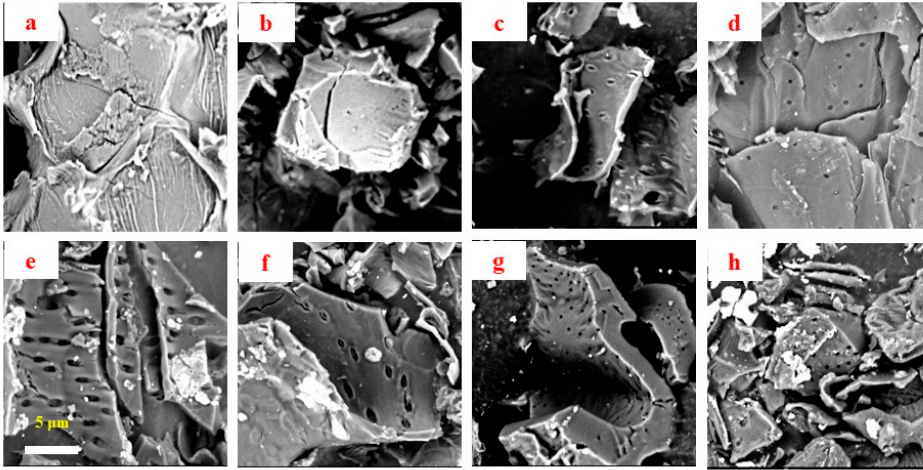
Figure 1. SEM images of raw ( a ) and carbonized ( b – h ) Camellia oleifera fruit shell (COS) samples obtained at 250, 350, 450, 550, 650, 750 and 850 °C.